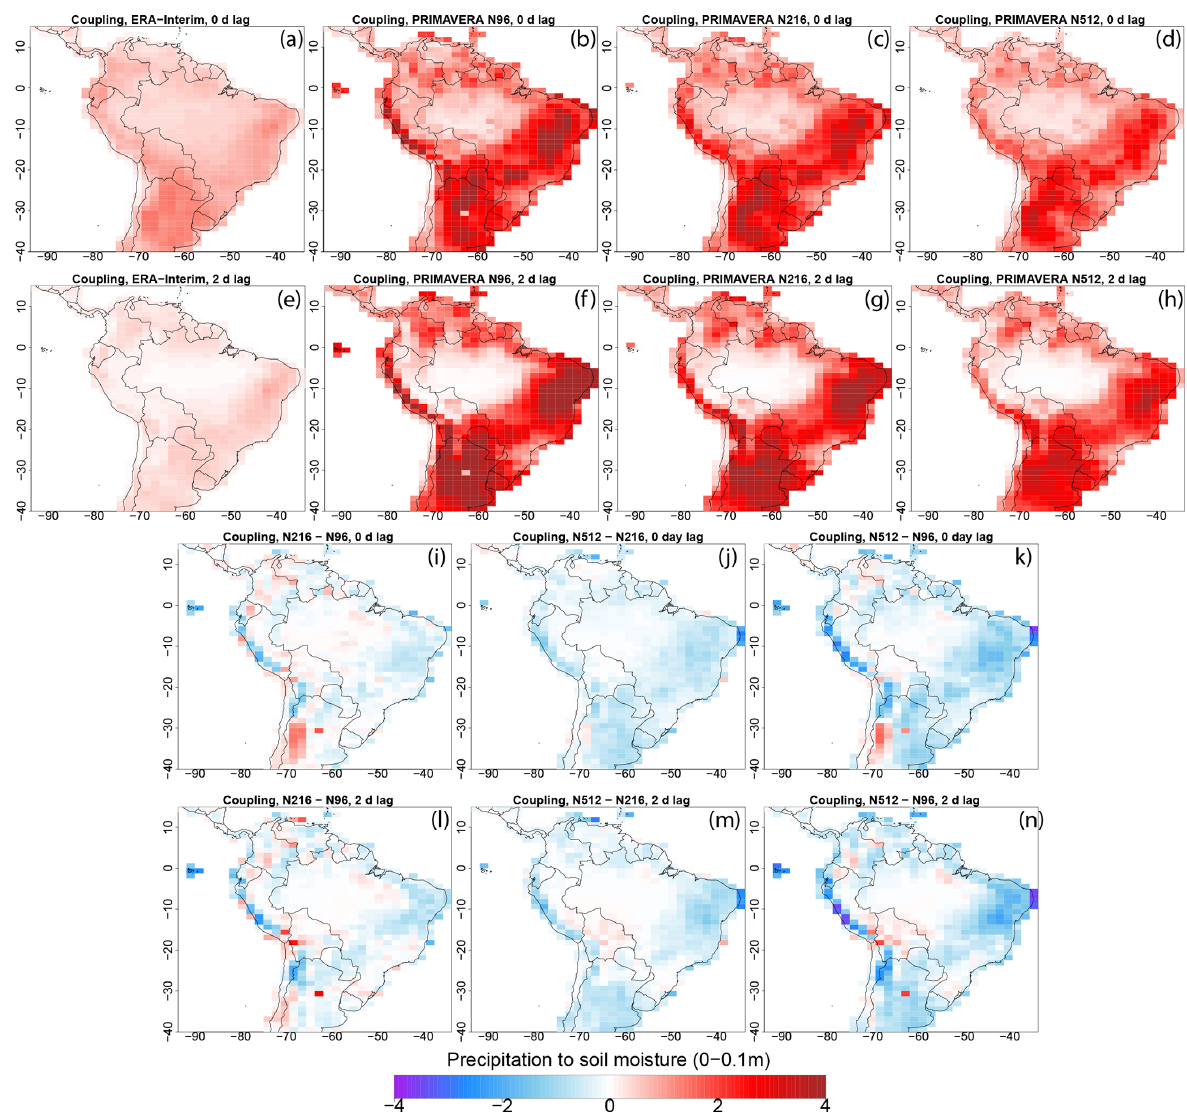
Figure 7. (a) Observed (ERA-Interim) and (b) N96, (c) N216, and (d) N512 coupling strength ( r a,b σ b ) between daily precipitation and soil moisture (in the top 0.1m of soil) during the southern summer wet season (DJF), over the period 1979–2014. Two-dimensional time lag (i.e. the soil situation 2d after precipitation) for (e) ERA-Interim, (f) N96, (g) N216, and (h) N512. (i) N216–N96, (j) N512–N216, and (k) N512–N96 coupling strength. (l, m, n) As for (i) , (j) , and (k) but with a 2d time lag between precipitation and soil